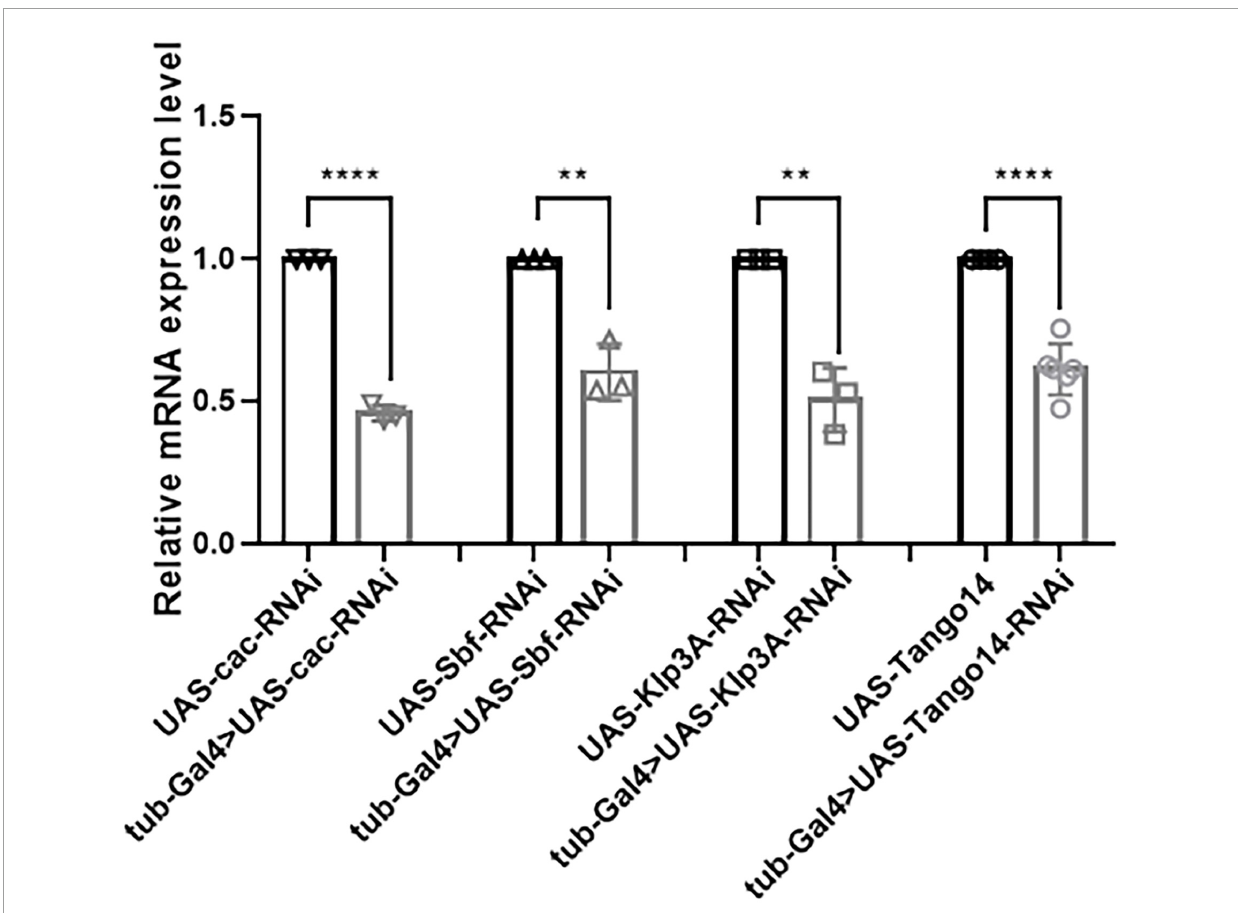
FIGURE7 Knockdown efficacy of knockdown fly lines. Relative expression of mRNA in Cac knockdown flies, Sbf knockdown flies, Klp3A knockdown flies, Tango14 knockdown flies, and wild-type flies. ** P < 0.01, **** P <